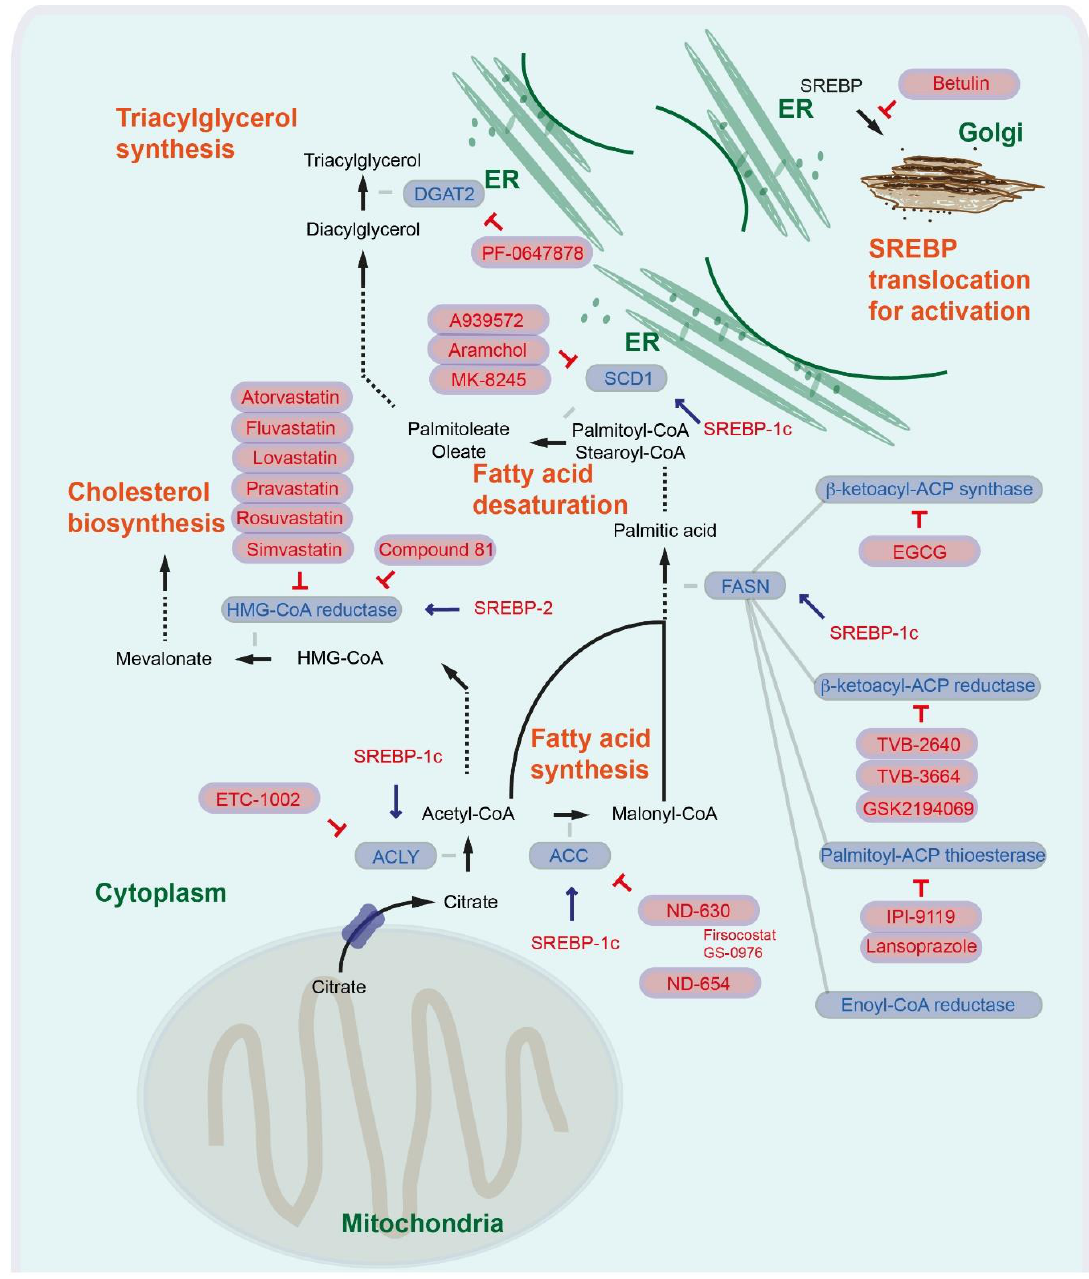
Figure 1. Regulation of fatty acid synthesis, fatty acid desaturation, triacylglycerol synthesis, cholesterol synthesis, and SREBP translocation. The inhibition symbols are colored in red. Bempedoic acid (ETC-1002, 8-hydroxy-2,2,14,14-tetramethylpentadecanedioic acid) is an ACLY